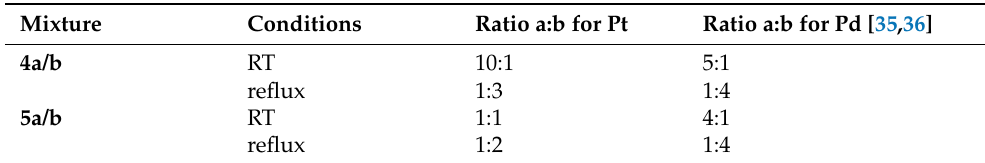
Table 1. Regioisomeric ratios obtained by the 1 H NMR integration of the reaction performed under different conditions.